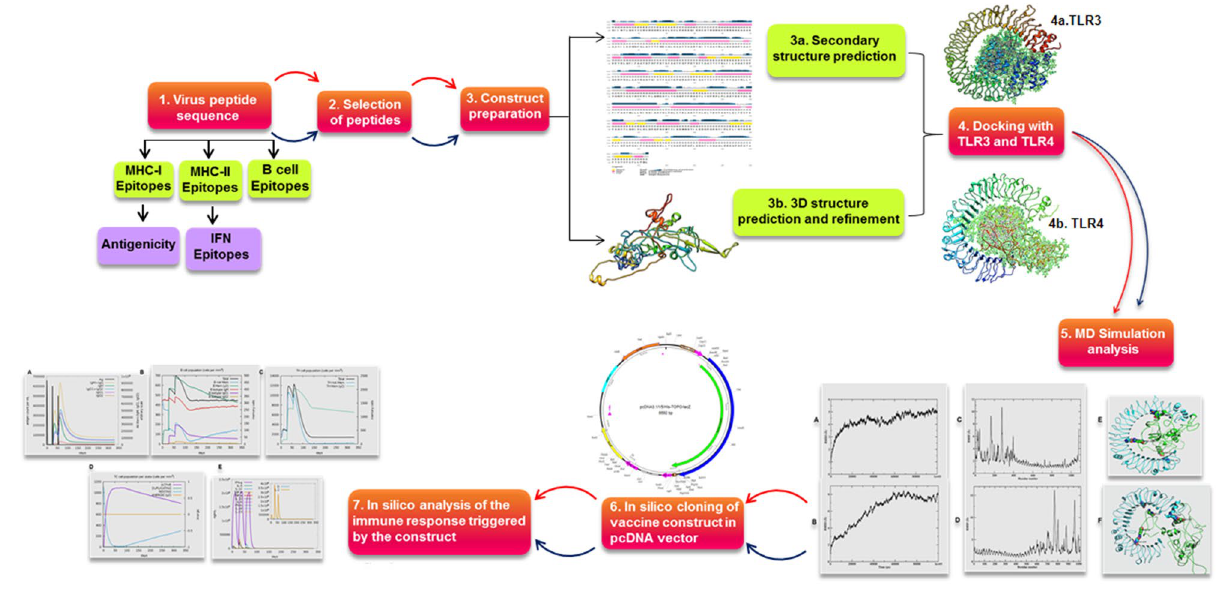
Figure 1. An overview of steps used in designing the chimeric vaccine